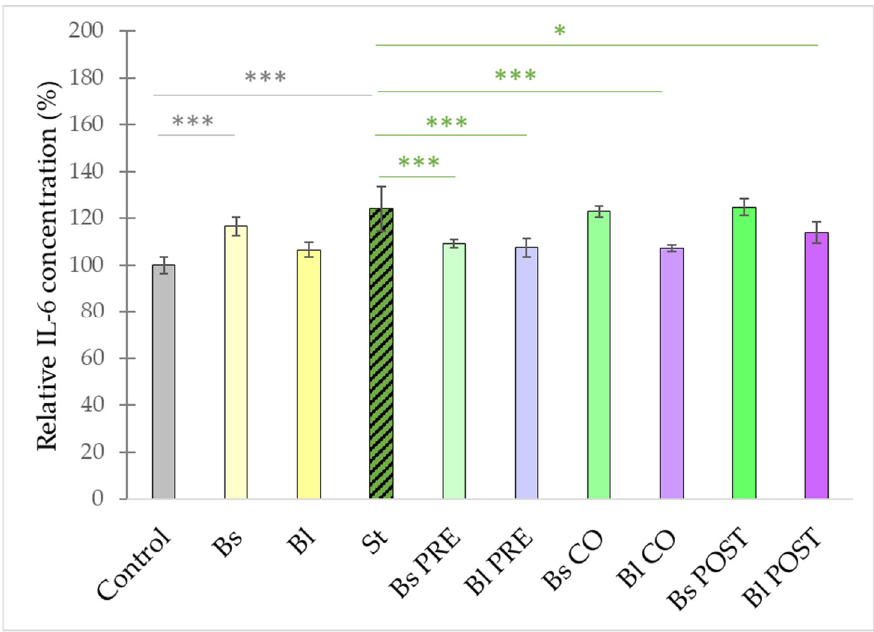
Figure 4. Induction of IL-6 secretion of IPEC-J2 cells after stimulation with S. Typhimurium, B. licheniformis, and B. subtilis . B. licheniformis and B. subtilis were added 1 h before (pre-treatment), at the same time as (co-treatment), or 1 h after (post-treatment) the addition of S. Typhimurium. B. licheniformis and B. subtilis were added in 10 8 CFU/mL and S. Typhimurium was added in 10 6 CFU/mL concentration. Control : plain cell culture medium treatment; St : S. Typhimurium 10 6